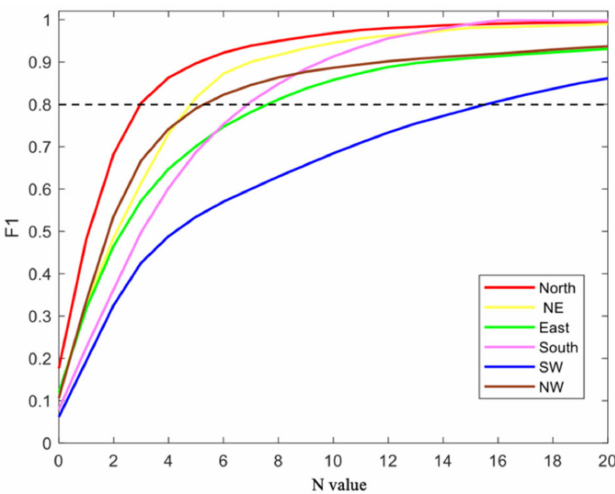
Figure 14. F1-measure of shoreline detection in different regions. NE, SW, and NW represent the northeast, southwest, and northwest, respectively. Table 5. Performance evaluation of shoreline detection in different